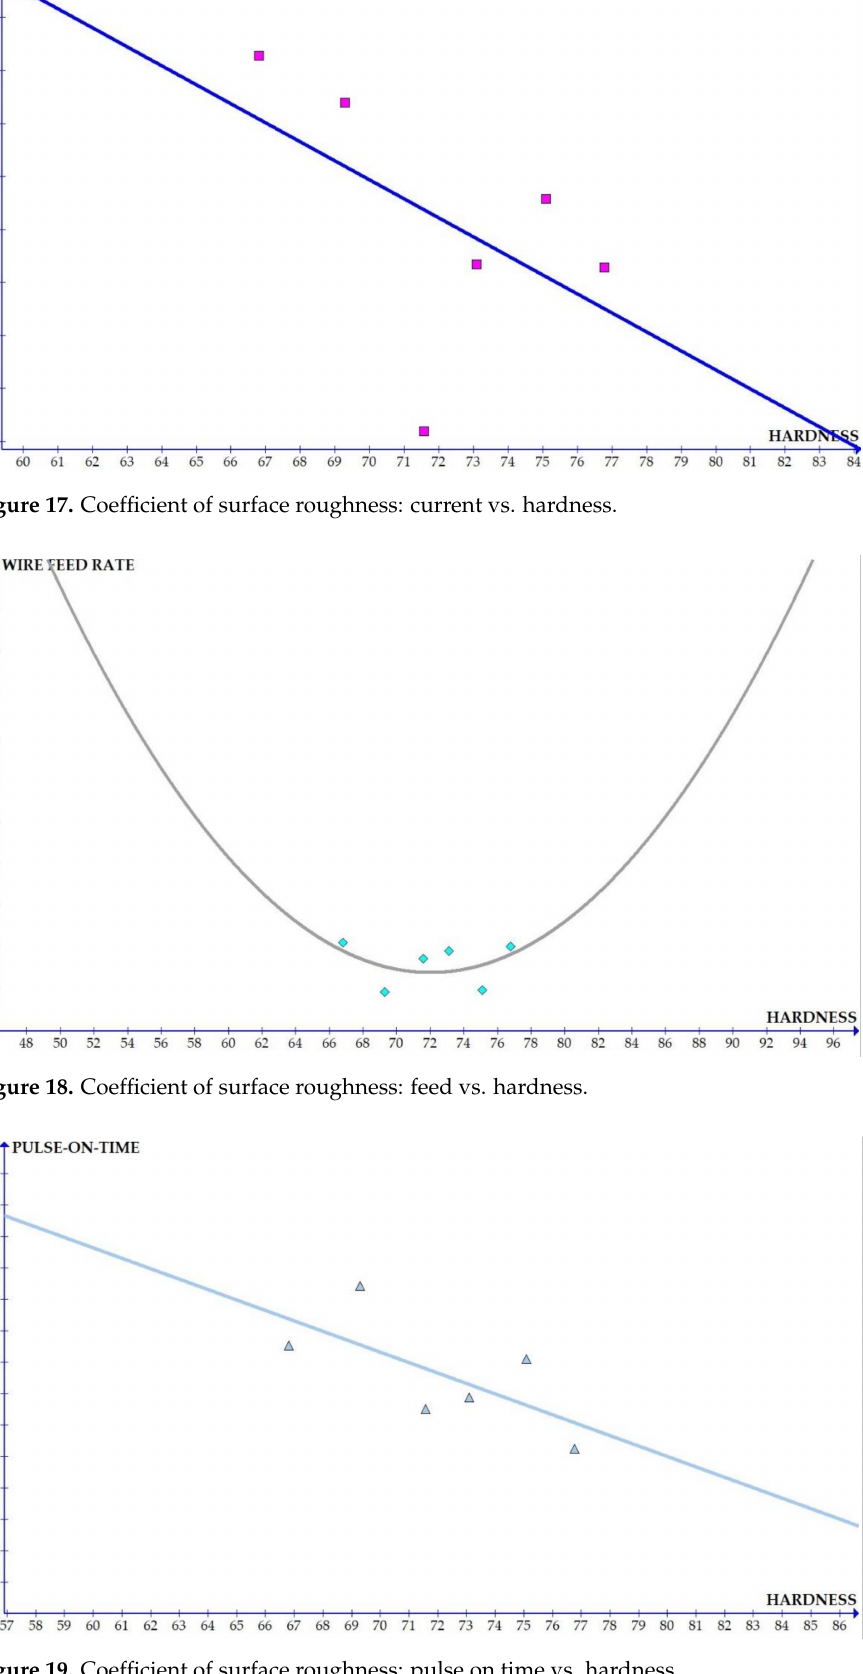
Figure 19. Coefficient of surface roughness: pulse on time vs.